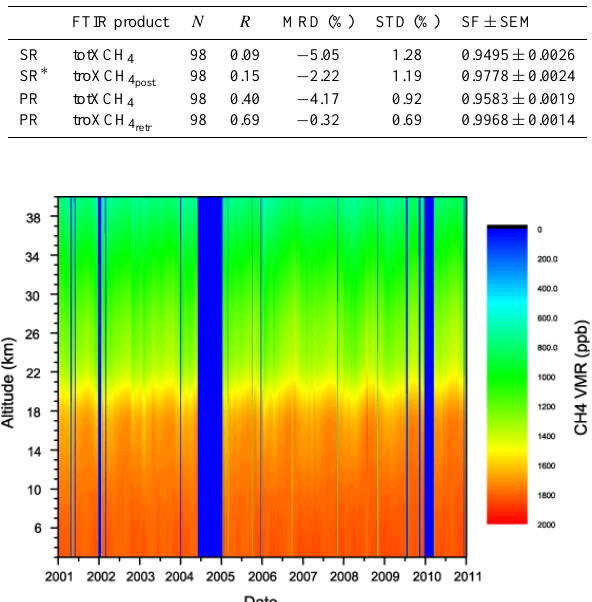
Fig. 7. Retrieved CH 4 profile time series for the period 2001–2010.